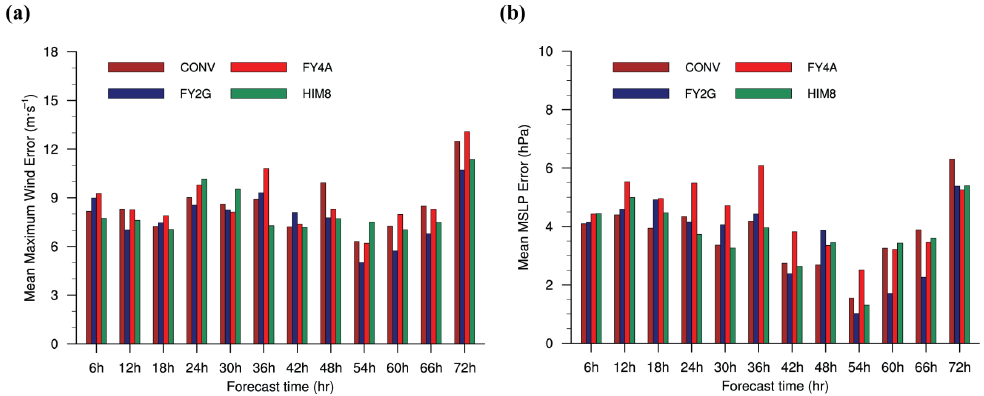
Figure 17. The comparison forecasts for every 6 h integration time to 72 h for ( a ) the average maximum surface winds, and ( b ) for the average of minimum MSLP difference from the Joint Typhoon Warning Centre (JTWC) observed best-track data from all the experiments of TC PABUK.